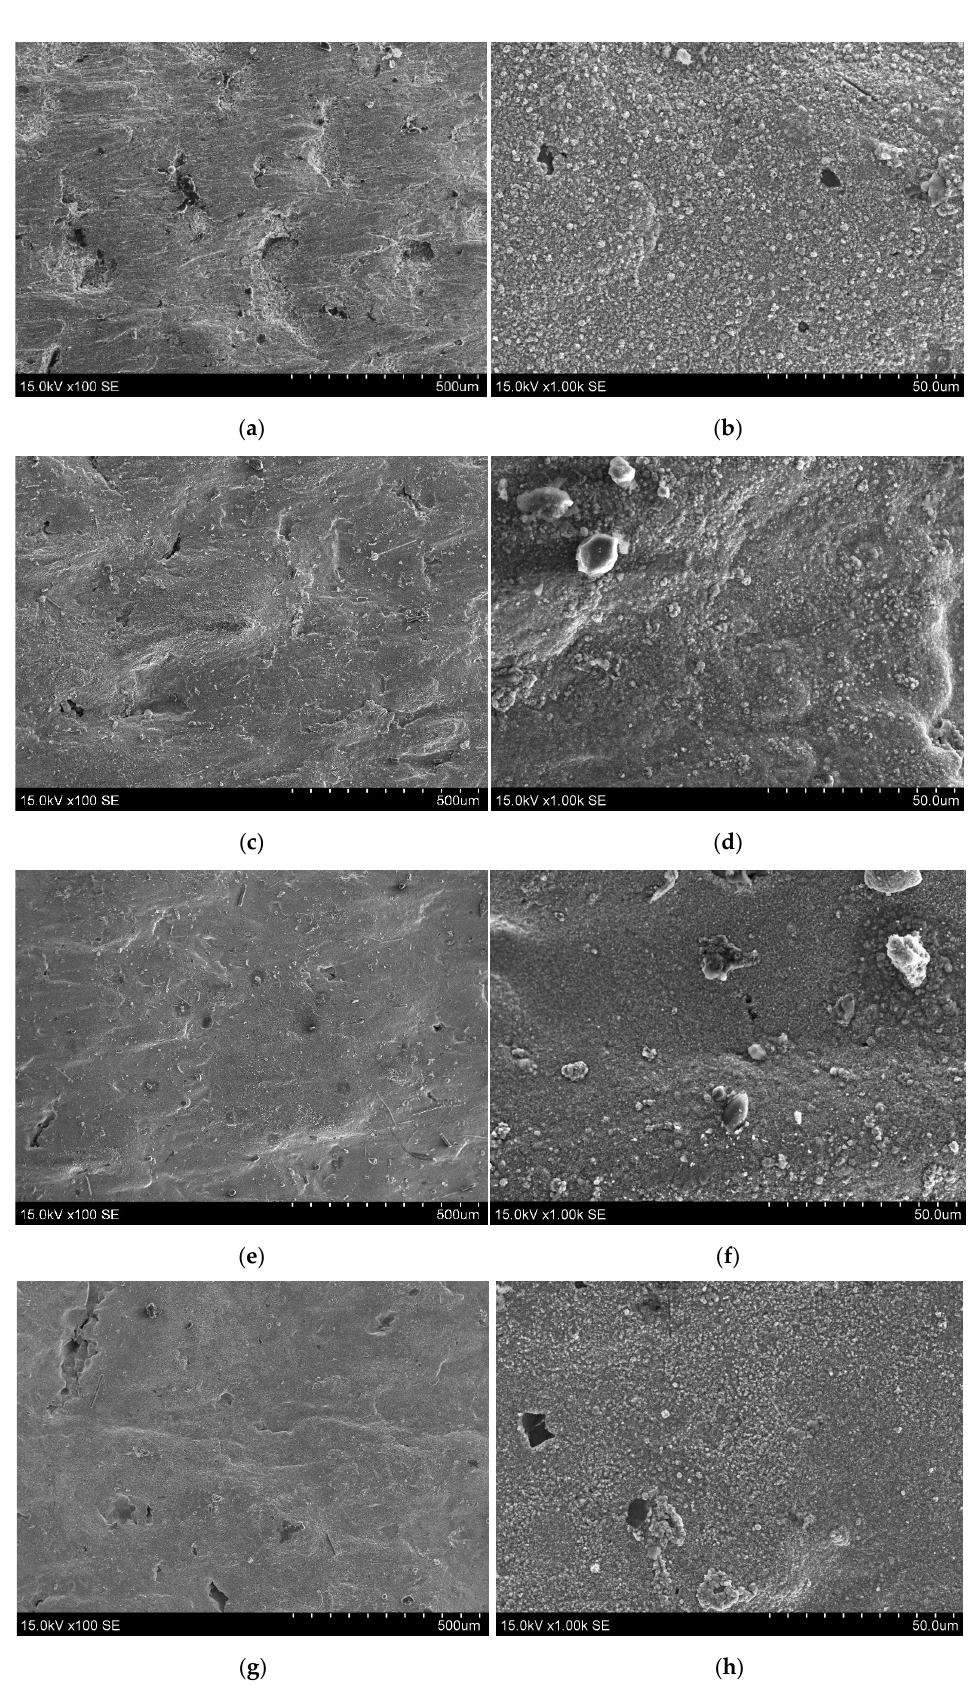
Figure 7. SEM micrographs of uncoated steel before ( a , b ) and after ( c , d ) 5, ( e , f ) 15, and ( g , h ) 25 heat treatment cycles. Before heat treatment of the Al 2 O 3 coating (Figure 8 a, b), its surface consists of splats and semi-molten particles. No apparent defects, such as cracks or delamination, were ob- served in the surface structure. After 5 heating cycles (Figure 8 c, d), the surface view is somewhat similar to the surface of the untreated alumina coating. However, the quantity of small particles is higher. Much like in the steel sample case, many of those tiny particles are leftover products of burned straw pellets that were not cleaned thoroughly, but over- all, the coated surface remained intact. After 15 (Figure 8 e, f) heating cycles, no additional changes in surface morphology were observed. However, after 25 heating cycles, a visibly larger melted area appears (Figure 8h), but the overall structure and morphology of the coatings seem to be similar, but with some defects starting to take shape. ( a )